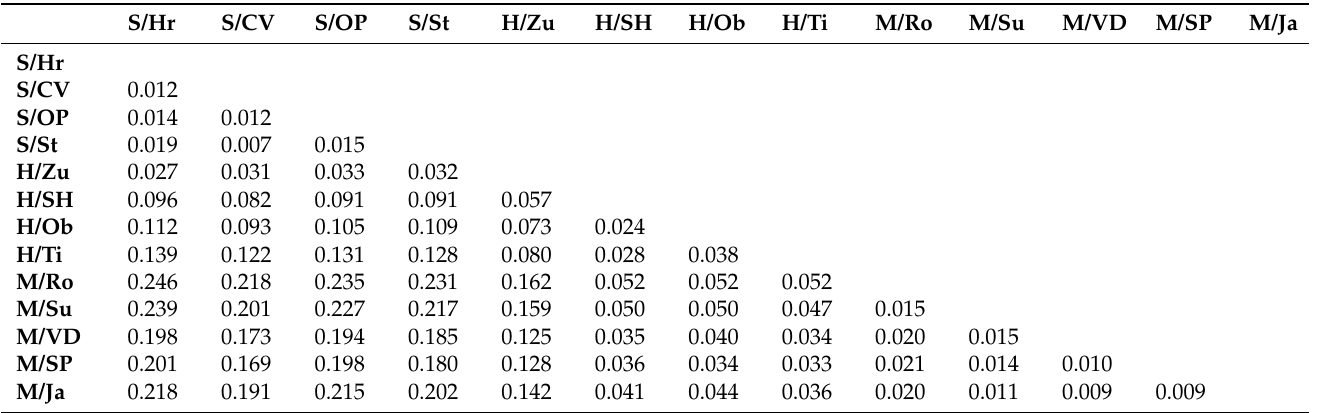
Table 4. Genetic distance matrix calculated as Nei’s [32] unbiased measure of genetic